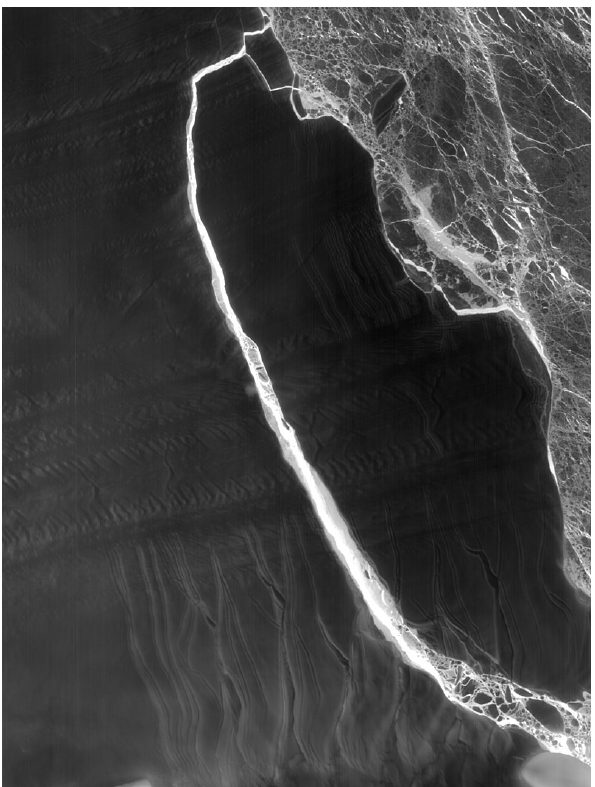
Figure 1. The A-68 iceberg. The fractured berg and shelf are visible in these images, acquired on 21 July 2017, by the thermal infrared sensor (TIRS) on the Landsat 8 satellite. Credit: NASA Earth Ob- servatory images by Jesse Allen, using Landsat data from the U.S. Geological